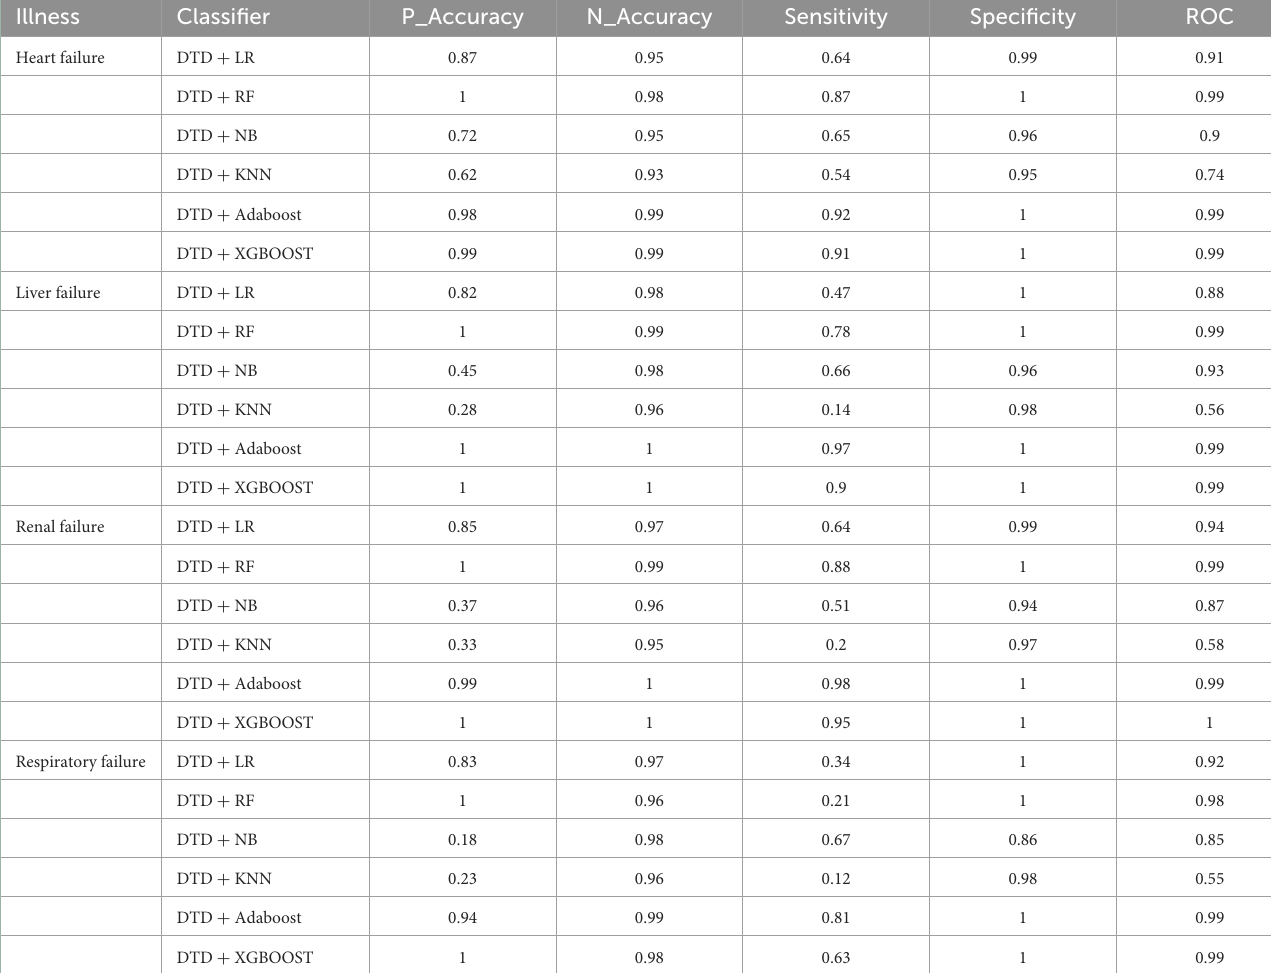
TABLE 6 Multimodal data experiments